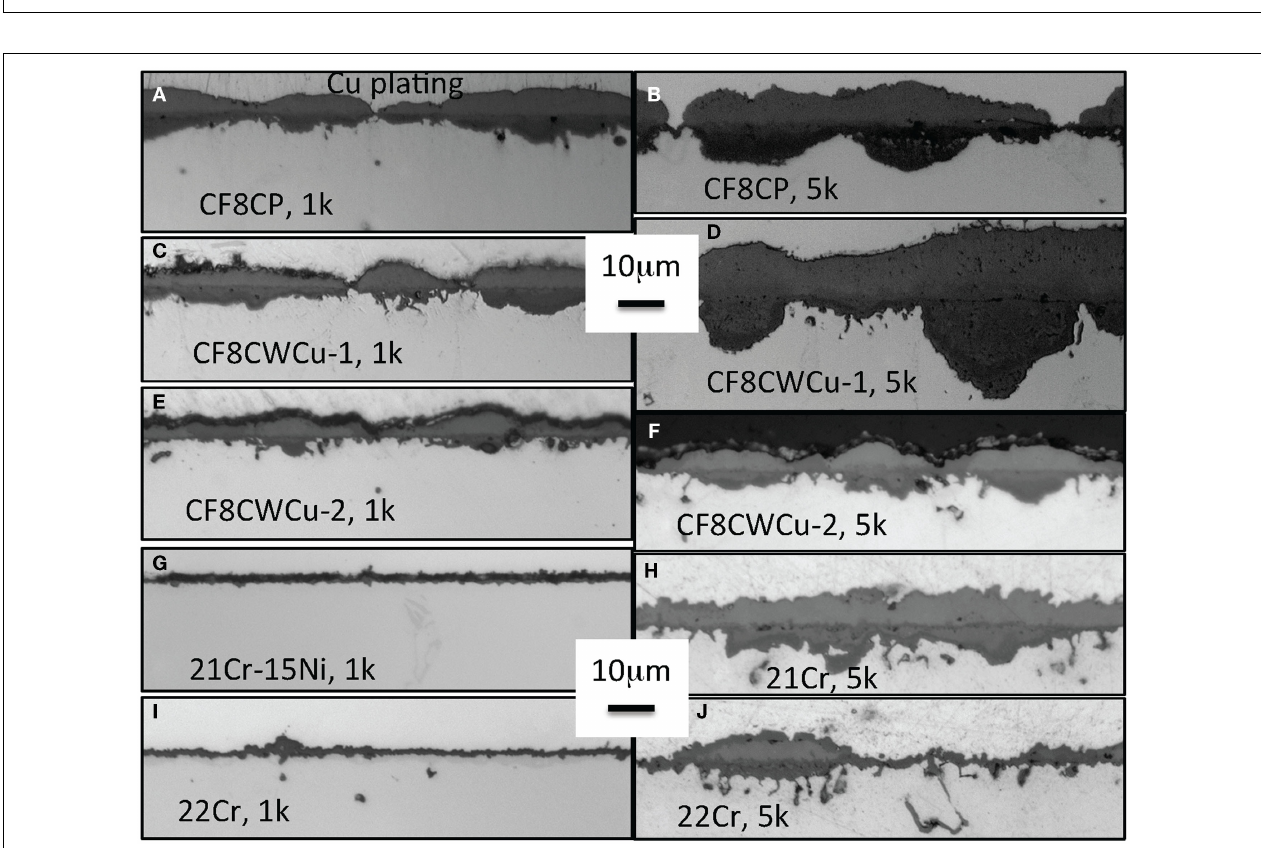
FIGURE 2 | Cross-section optical micrographs after exposure in air +++ 10% H 2 O at 650°C, (A) CF8CP, 1000h, (B) CF8CP, 5000h, (C) CF8CWCu-1, 1000h, (D) CF8CWCu-1, 5000h, (E) CF8CWCu-2, 1000h, (F) CF8CWCu-2, 5000h, (G) 21Cr-15Ni, 1000h, (H) 21Cr-15Ni, 5000h (I) 22Cr-17.5Ni, 1000h, and (J) 22Cr-17.5Ni, 5000h